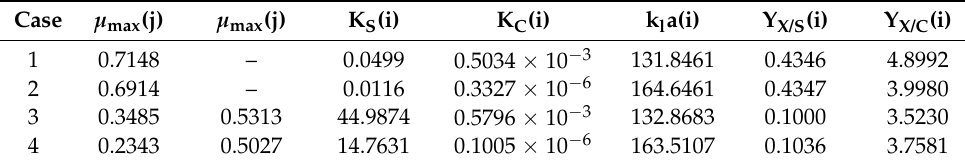
Table 8. Values of parameters in models, where i = 1, 4, and j = 1, 6.